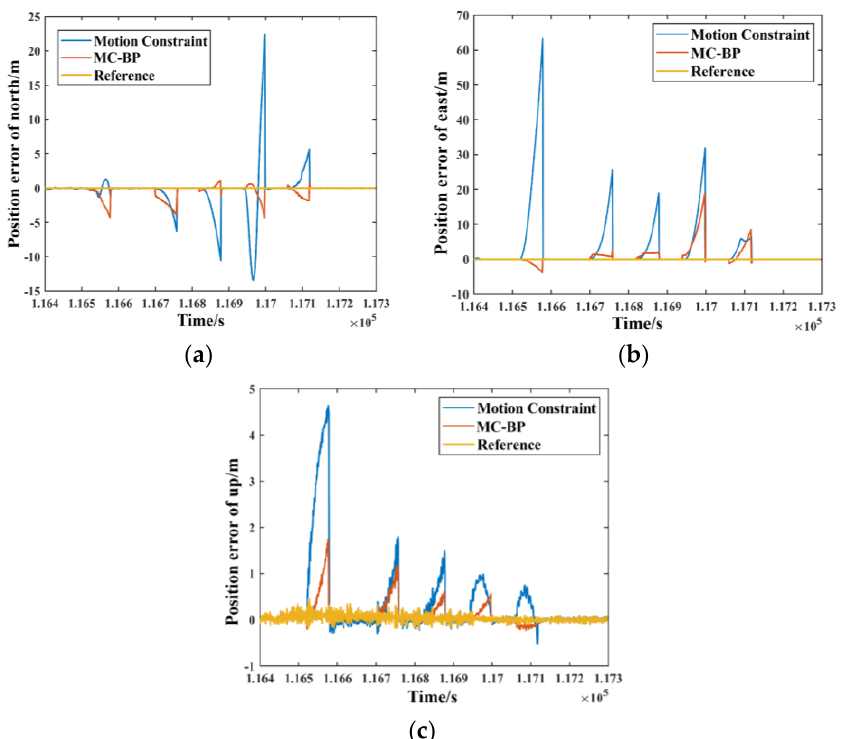
Figure 12. Positioning errors of classical GNSS/INS integration algorithm during GNSS outages in offshore experiment.